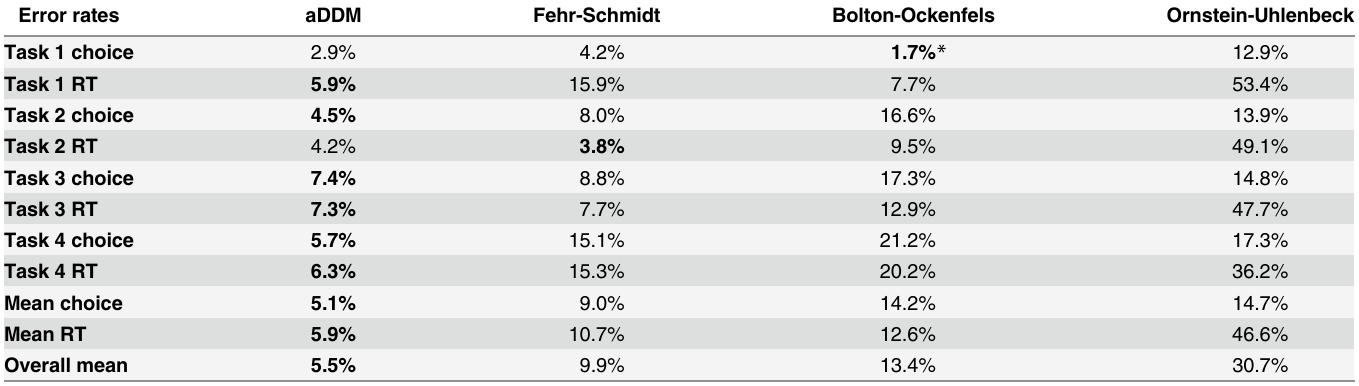
Table 1. Model error rates. As described in the results, we assessed each model ’ s prediction accuracy by calculating the mean absolute difference between the model prediction and the observed data across the bins in Figs 2 – 5. For each set of data (task + choice/RT) the most accurate model is indicated in bold. The asterisk in the first row indicates that the Bolton-Ockenfels model was actually fit to the choice data from Task 1, so it is not surprising that it pro- vides the best fit. Error rates aDDM Fehr-Schmidt Bolton-Ockenfels Ornstein-Uhlenbeck